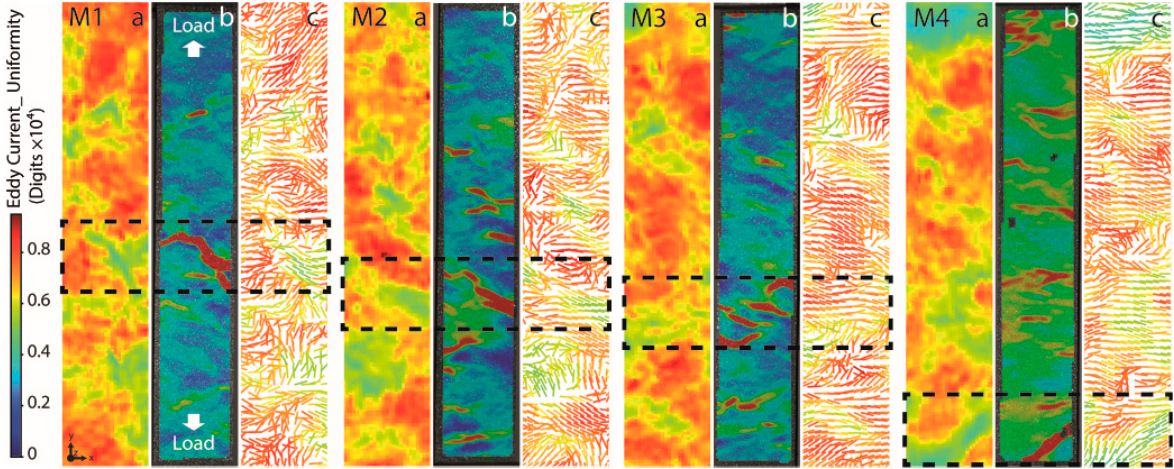
Figure 9. EC uniformity/principal fibre angle measurements along with the DIC major strain maps for tensile coupons of 2.5 cm width from the Mono sample. The maximum strain in DIC maps was set to 1.5% to enable data comparison.